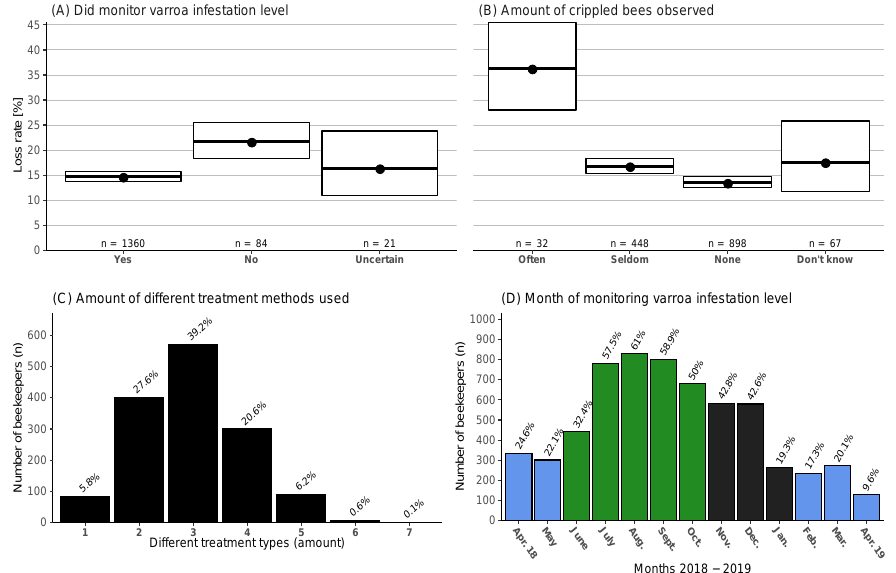
Figure 9. ( A ) Categories for if monitoring for varroa mites during the period April 2018–April 2019 was practiced and the corresponding winter honey bee colony loss rates (and 95% CI). ( B ) If and how often the participants noticed bees with crippled/deformed wings in their colonies (during summer season) in four categories and their loss rate (and 95% CI). ( C ) Distribution of how many different treatment methods (including drone brood removal) per operation were used, i.e., formic acid—short term and thymol would be two. ( D ) Histogram of which months monitoring of varroa infestation level (e.g., counting mite fall) was done and by how many beekeepers ( n = 1360) in the survey. Spring, summer, and winter are color coded; see Figure